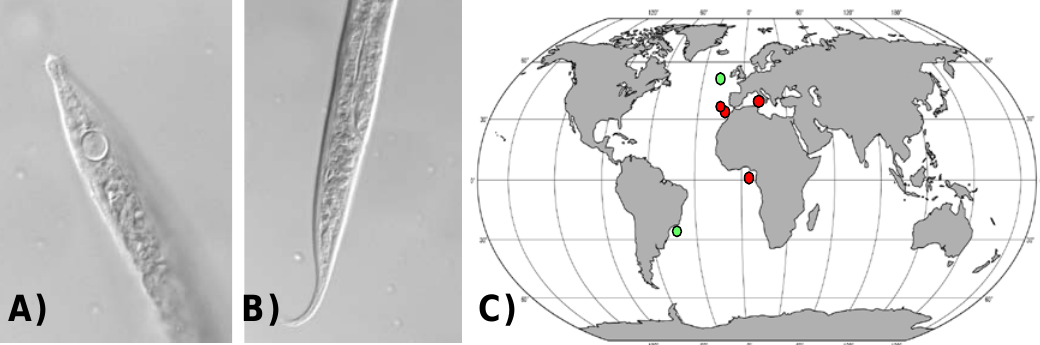
Figure 4. Pictorial key for Manganonema media ( A–C ), Manganonema sp. 1 ( D–F ) and Manganonema sp. 2 ( putative species ) ( G–I ) with the representation of the anterior and posterior ends, geographical distribution (red circles indicate records in the present study, green circles indicate records available in literature) and short diagnosis of each species. Reported are ratio a = body length divided by maximum body diameter, b = body length divided by pharyngeal length, c = body length divided by tail length, c' = tail length divided by anal body diameter, cbd = corresponding body